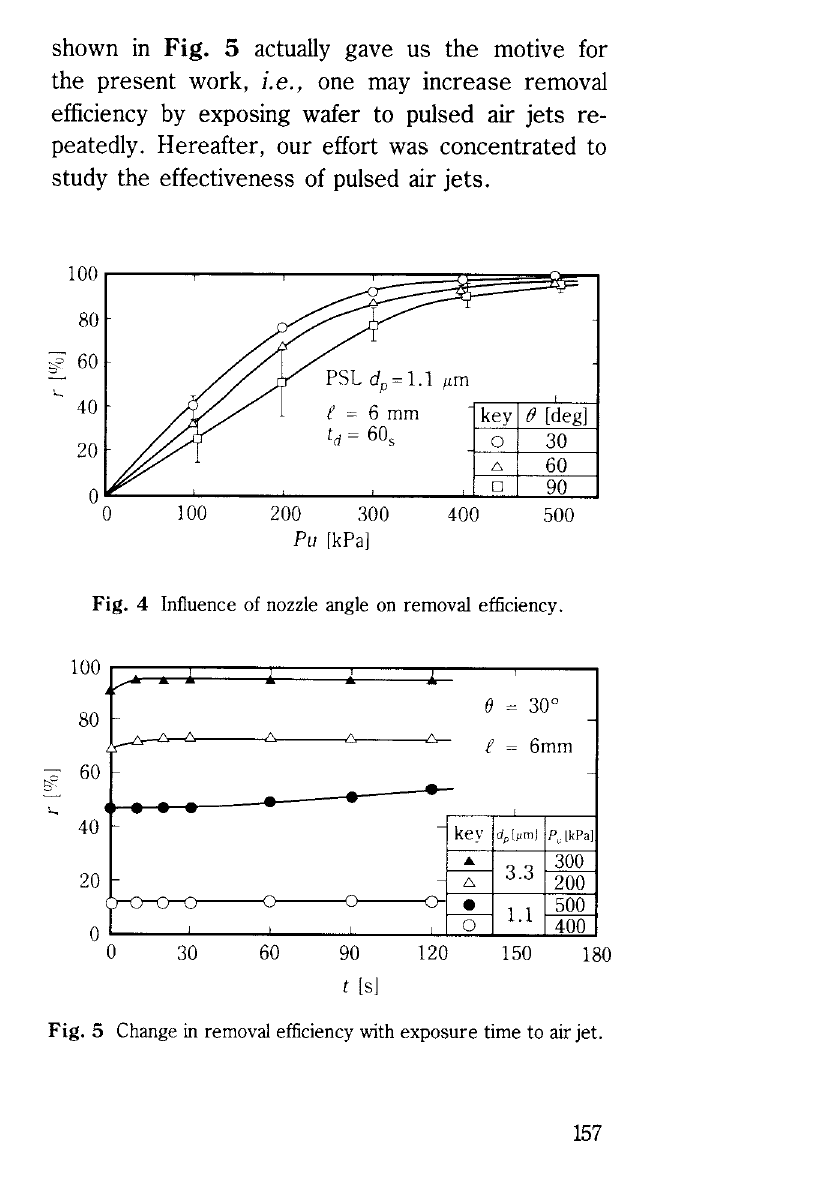
Fig. 3 Experimental setup for the preparation of particle-deposited wafer by gravitational settling.